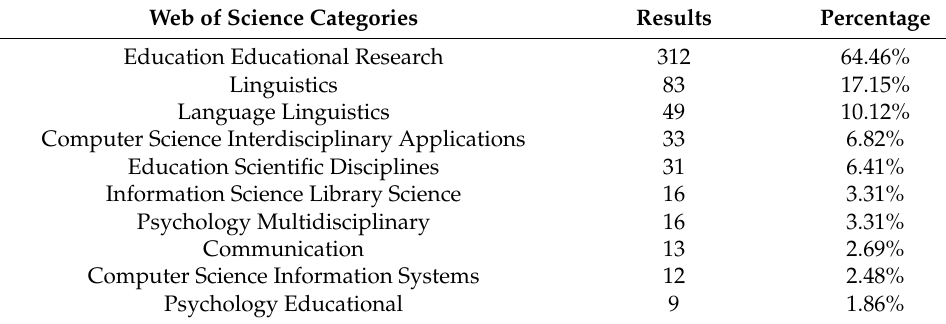
Figure 1. Publication trend of the studies on peer assessment in online language courses. Table 1. The top 10 Web of Science Categories with most search results.